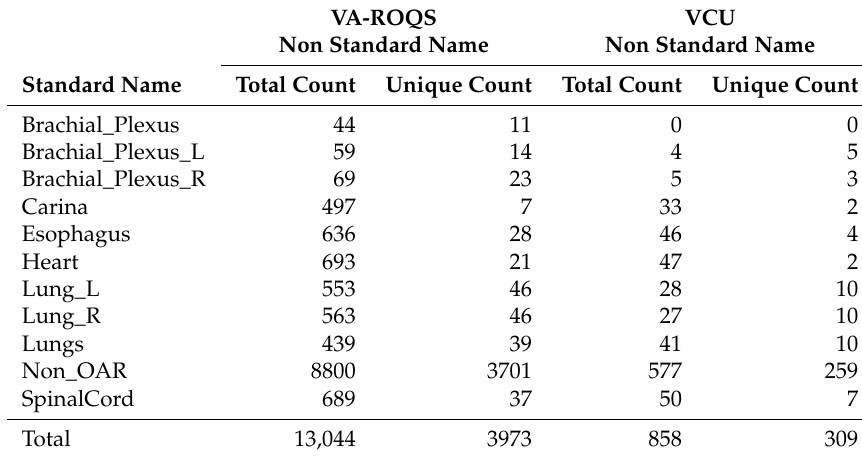
Table 1. Lung structure type distribution in VA-ROQS and VCU datasets.